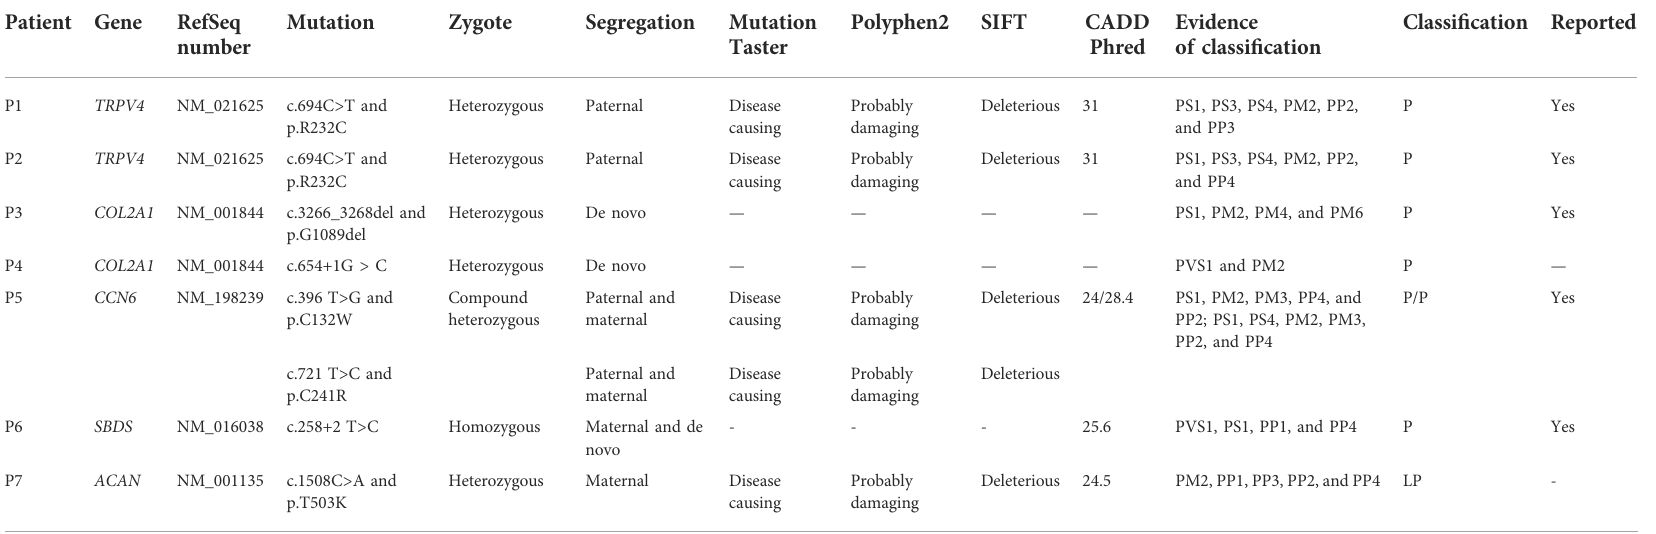
TABLE 2 Description of the variants and predictions for